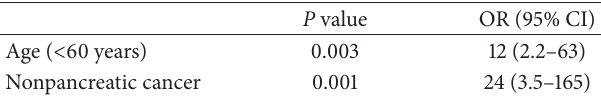
Table 5: Risk factors for overall complications after CSEMS deploy- ment (multivariate